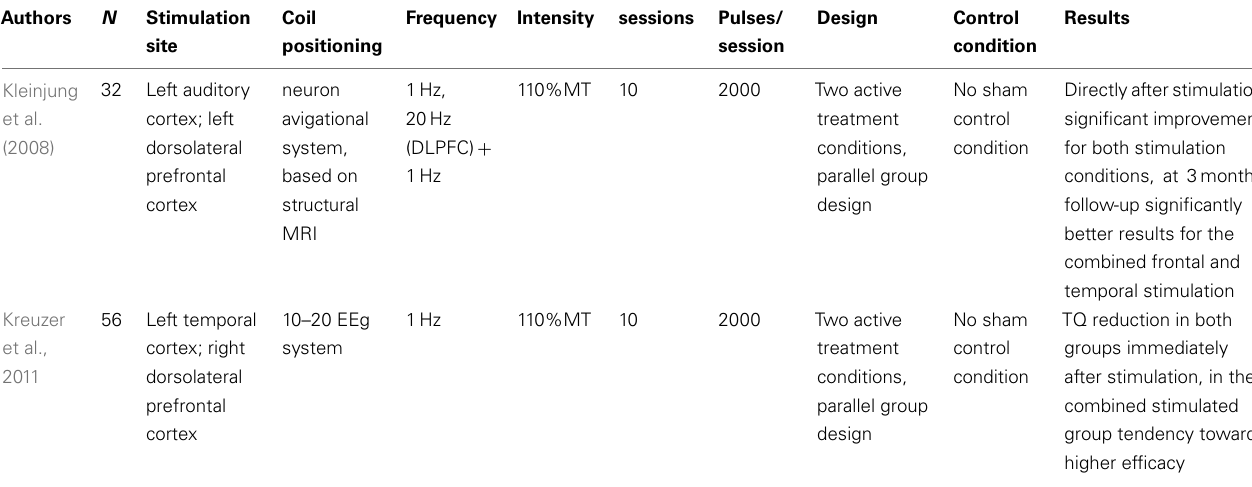
Table 5 | Effects of repeated sessions of rTMS over non-auditory brain areas. Authors